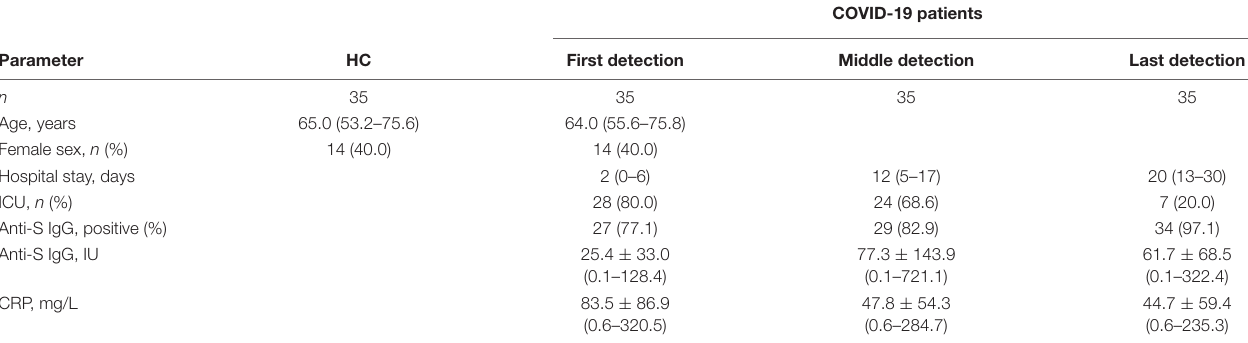
TABLE 1 | Demographics of the cohorts used in this